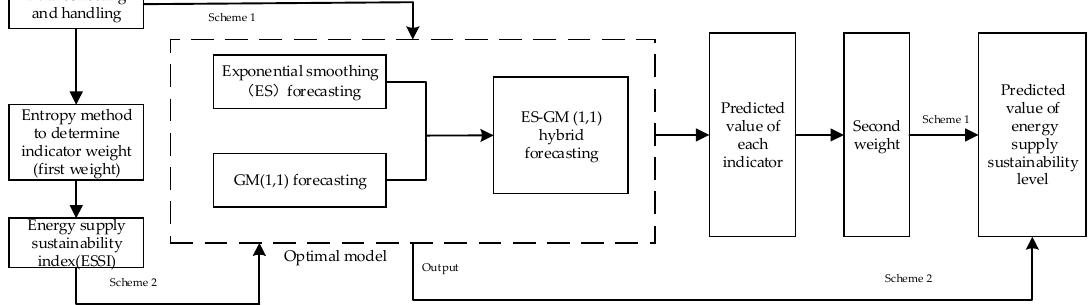
Figure 1. Forecasting principles and processes for energy supply sustainability.